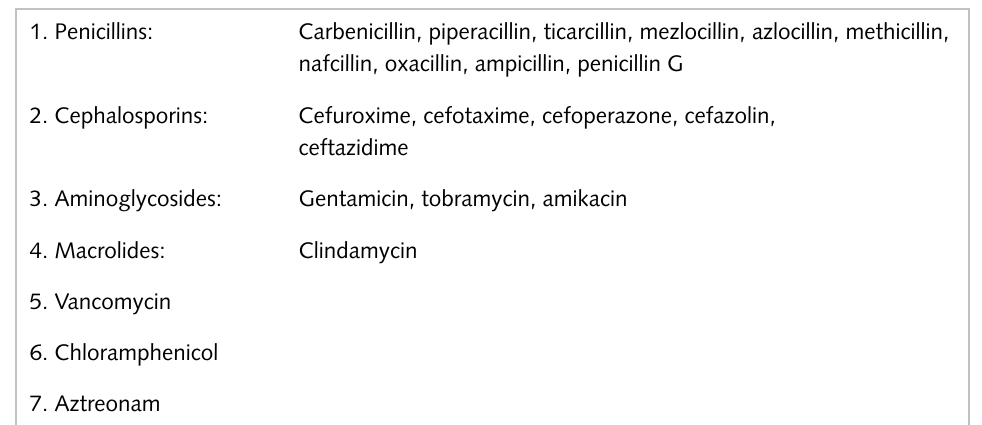
Table 9. Parenteral antibiotics for CSOM